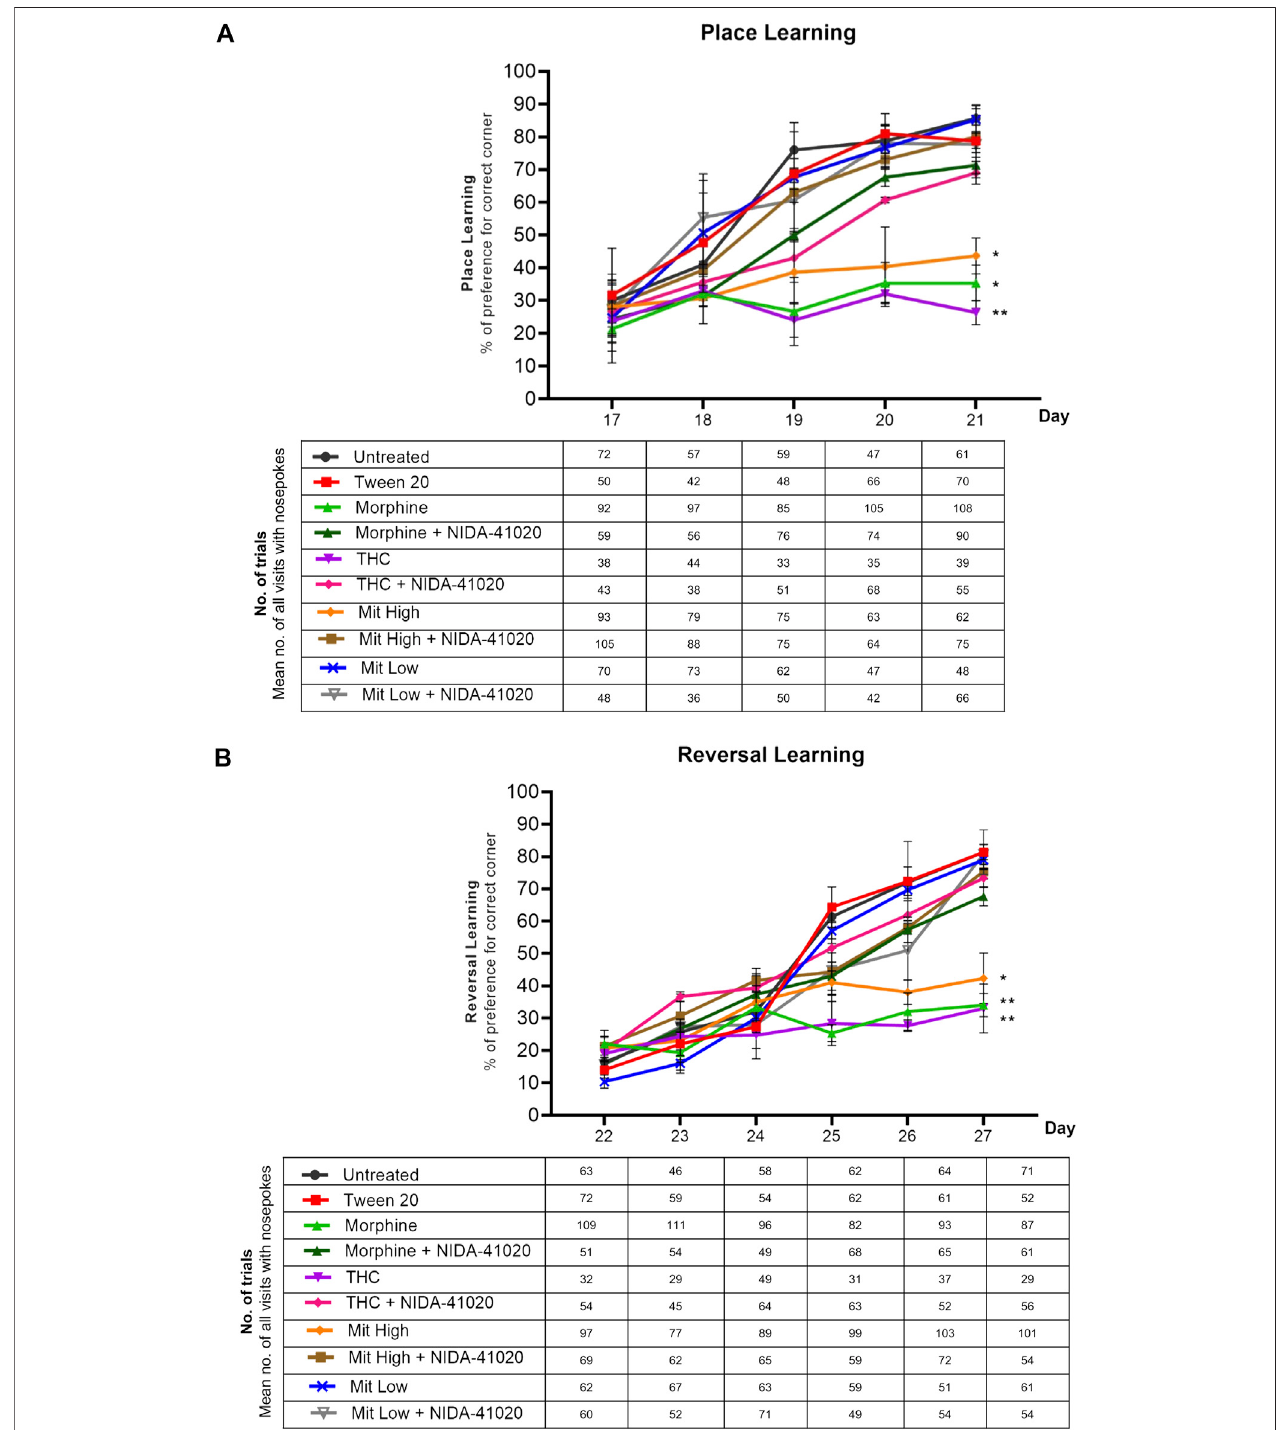
FIGURE 4 | Effects of drug intervention on place learning and reversal learning, and NIDA-41020 antagonism. Data are shown as the percentage of preference for the correct (water-reinforced) corner and number oftrials (the mean number of all visitswith nose pokes are shown in the table below the graph) (A) during the 5 days of place learning phase, as well as (B) 6 consecutive days of the reversal learning phase. Data revealed highly signi fi cant learning and reversal learning in untreated and Tween20control groups and thelow-dose mitragynine group. The morphine-, THC-, and high-dose mitragynine-treated groups failed toattain place learning and reversal learning. The cannabinoid CB 1 receptor antagonist NIDA-41020 signi fi cantly reversed morphine-, THC-, and mitragynine-induced place learning and reversal learning impairment in mice. * p < 0.05; ** p < 0.01 vs Tween 20 (two-way ANOVA with post-hoc Tukey; n (cid:1) 10/group).